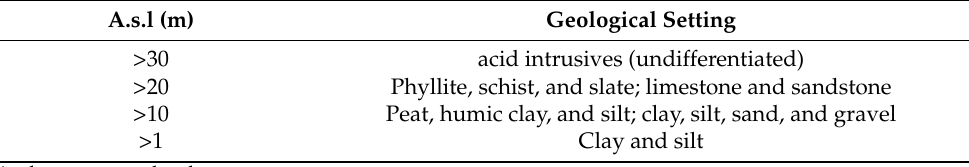
Table 2. The geological profile setting of the Langat Basin [34].